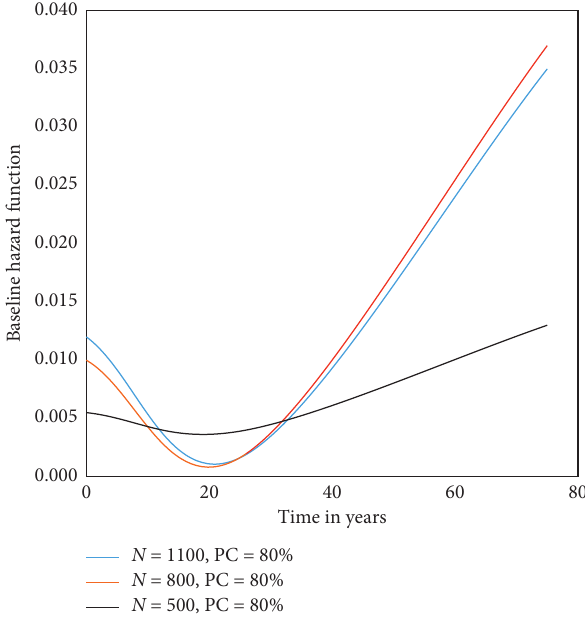
Figure 4: Baseline hazard function ( N